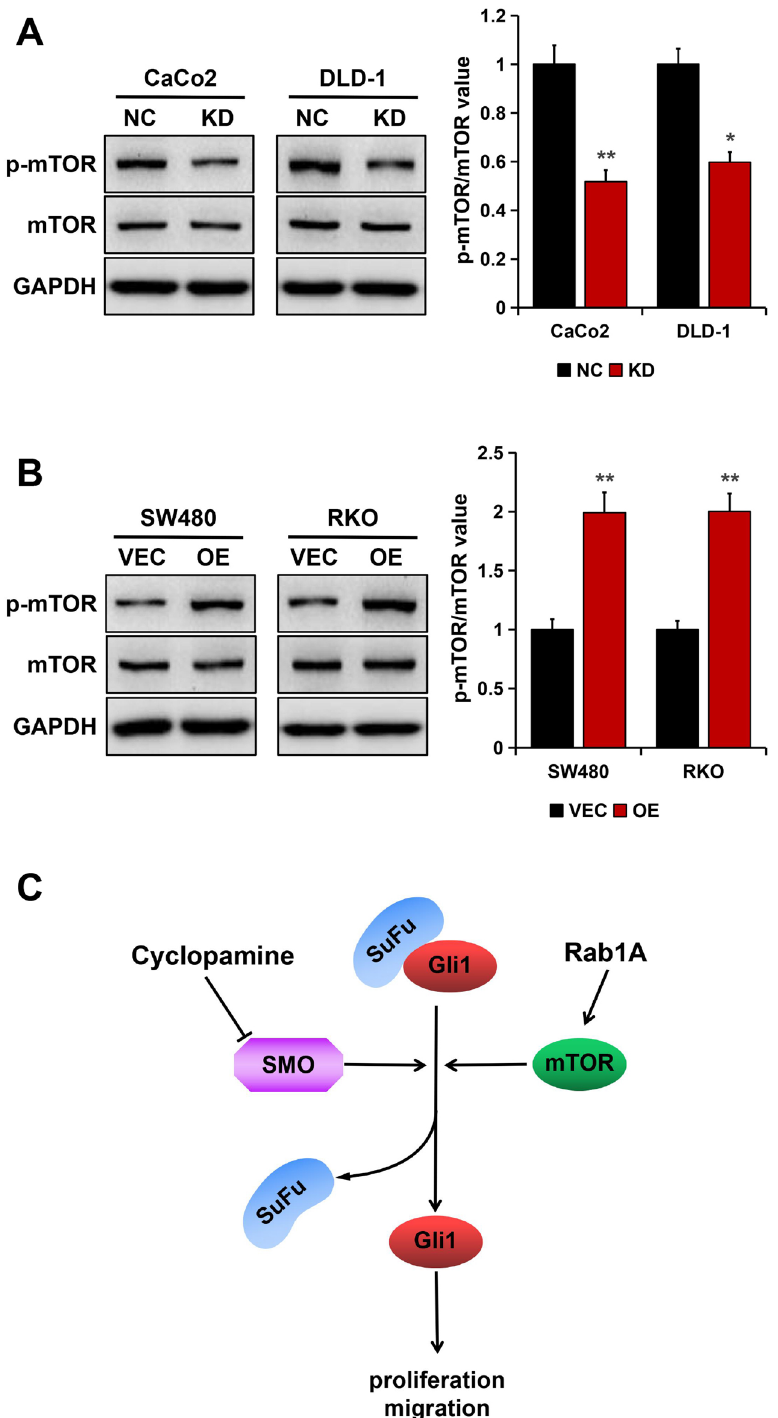
Figure 5. Rab1A regulated the phosphorylation of mTOR in CRC cells. ( A ) p-mTOR and mTOR expression in Rab1A-silenced cells as detected by Western blotting. ( B ) p-mTOR and mTOR expression in Rab1A- overexpressed cells as detected by Western blotting. ( C ) A proposed model for SMO-independent Gli1 upregulation regulated by Rab1A. Here cropped blots were displayed and all full-length blots are included in the Supplementary Information file. * P < 0.05, ** P <